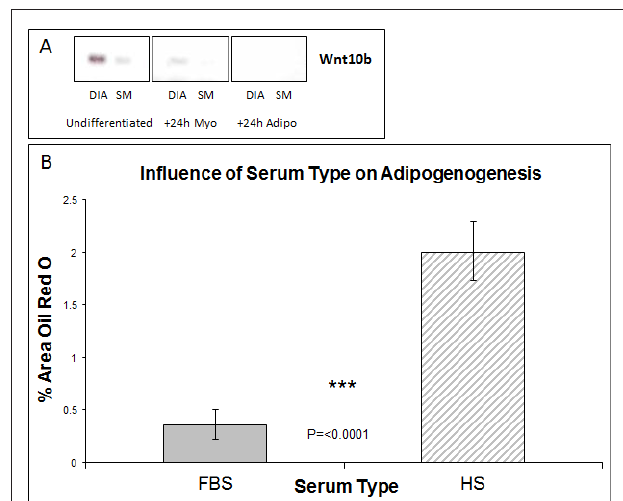
Figure 1 | Wnt Expression and The influence of serum type on adipogenesis. (a) Expression of Wnt 10b by RT-PCR in muscle stem cells derived from diaphragm (DIA) and semi-membranosus (SM) muscles: undifferentiated and +24 h myogenic and adipogenic differentiation. (B) Lipid accumulation was measured by Oil Red O staining at Day 6 of differentiation, for cells grown in media containing either foetal bovine serum (FBS) or horse serum (HS). ( n = 6, 15 FOV/rep). Error bars represent SD.